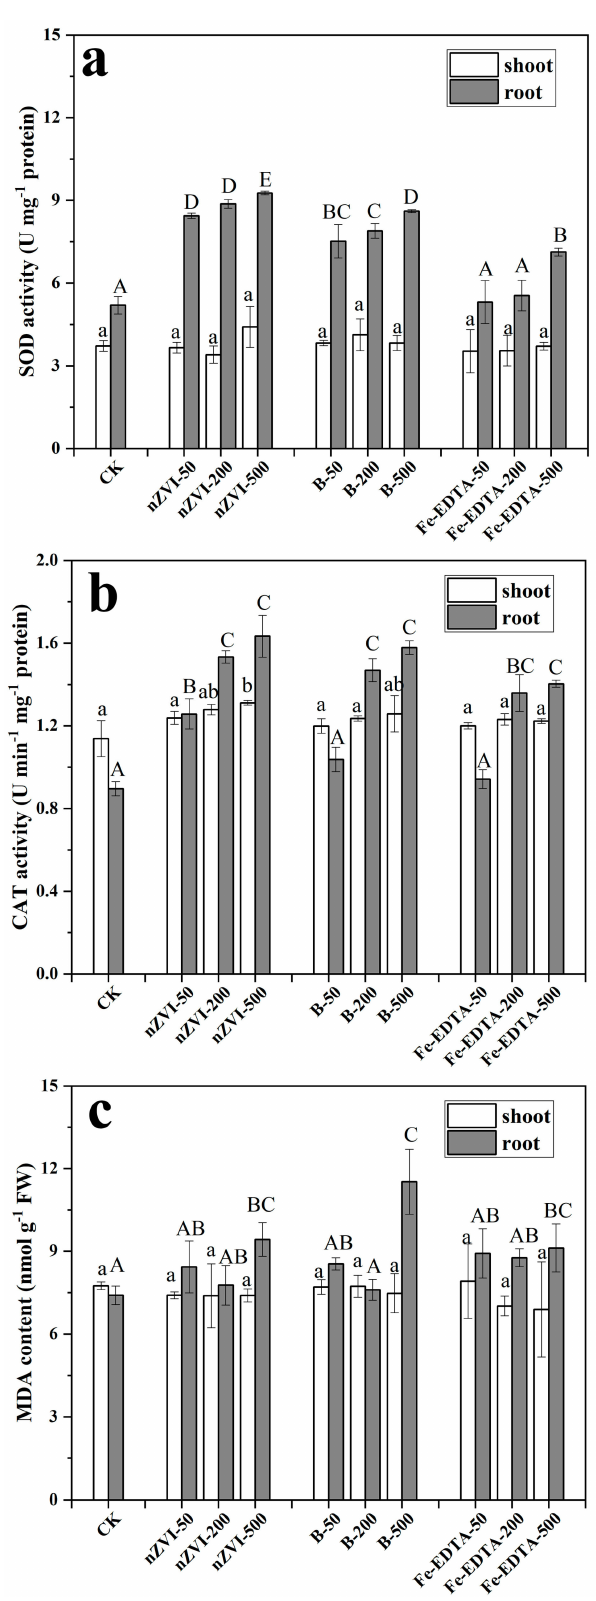
Figure 7. SOD ( a ), CAT ( b ) activities and MDA ( c ) contents in perennial ryegrass. Error bars indicate the standard deviation of the mean (n = 3). Lowercase and uppercase letters represent significant differences of shoots and roots among the different treatments determined by the Fisher least significant difference (LSD) test ( p <